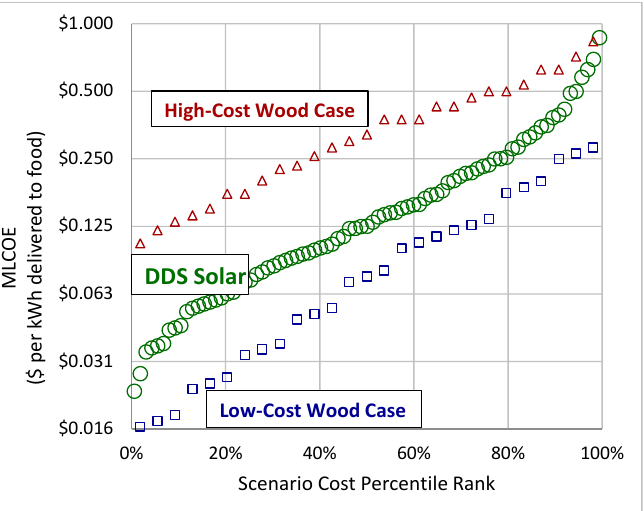
Figure 7. MLCOE distribution of DDS SEC compared with WC MLCOE. The SEC MLCOE is the central distribution illustrated with the green circles. The high cost WC case is illustrated with the triangles, while the low-cost WC case is illustrated with the squares. Note that the vertical axis has logarithmic scaling.